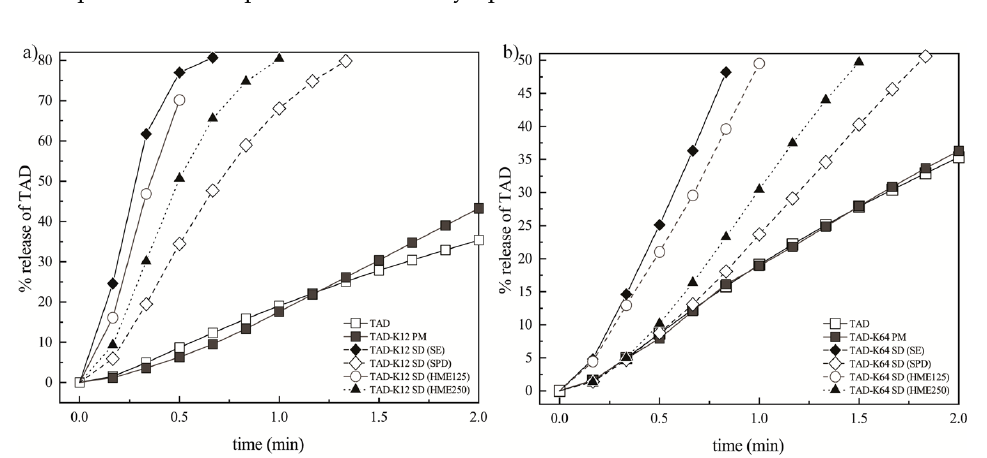
Figure 14. TAD release profile during 2 min: a) K12 groups and b) K64 groups.